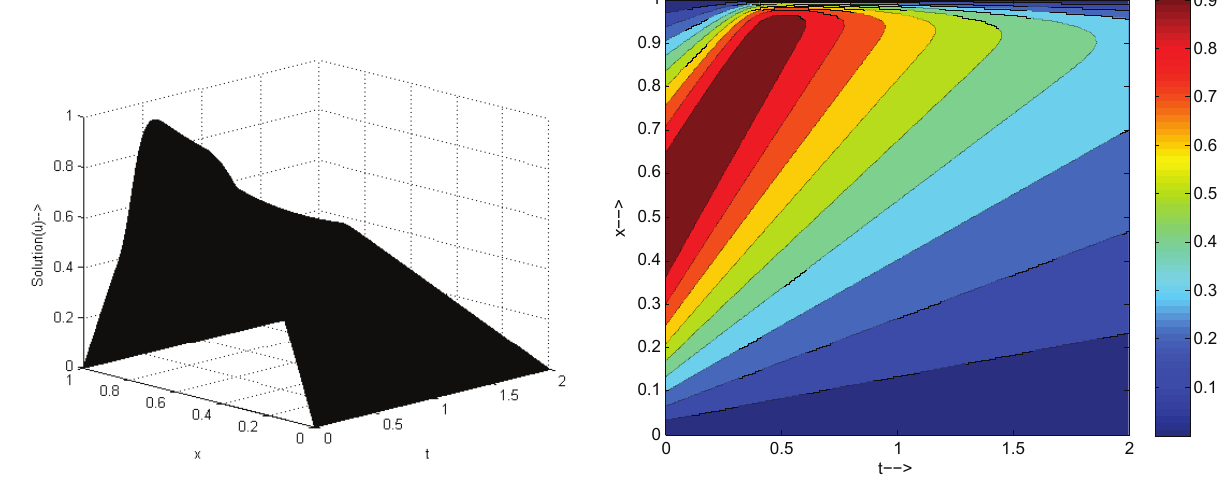
Fig. 4: Physical behavior of numerical solutions of Example 1 at different times in 3D and contour for Δx = 0.0125 , ν = 0.01 at different times with Δt = 0.001 .